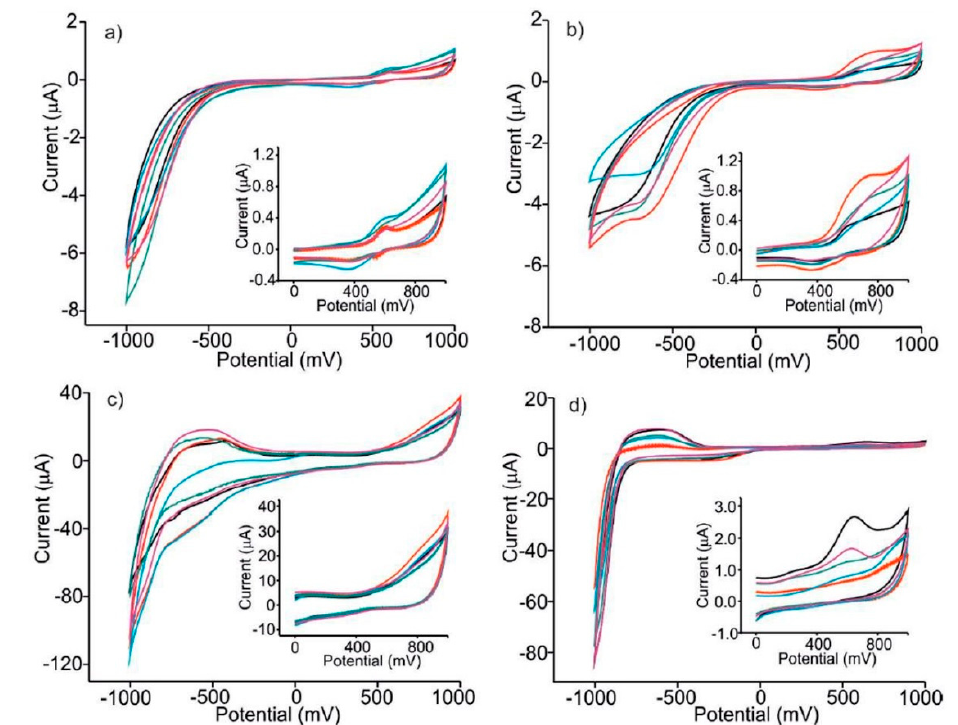
Figure 2. Cyclic voltammograms registered using four different carbon paste electrodes (CPEs) immersed in liqueur samples made from different varieties of apples. ( a ) Unmodified CPE; ( b ) ZnPc–CPE; ( c ) FePc–CPE; ( d ) CoPc–CPE. Apple varieties: Ligol (black), Kosztela (red), Grey Reinette (blue), Rubin (green), Cox Orange (purple). Reproduced from [43].